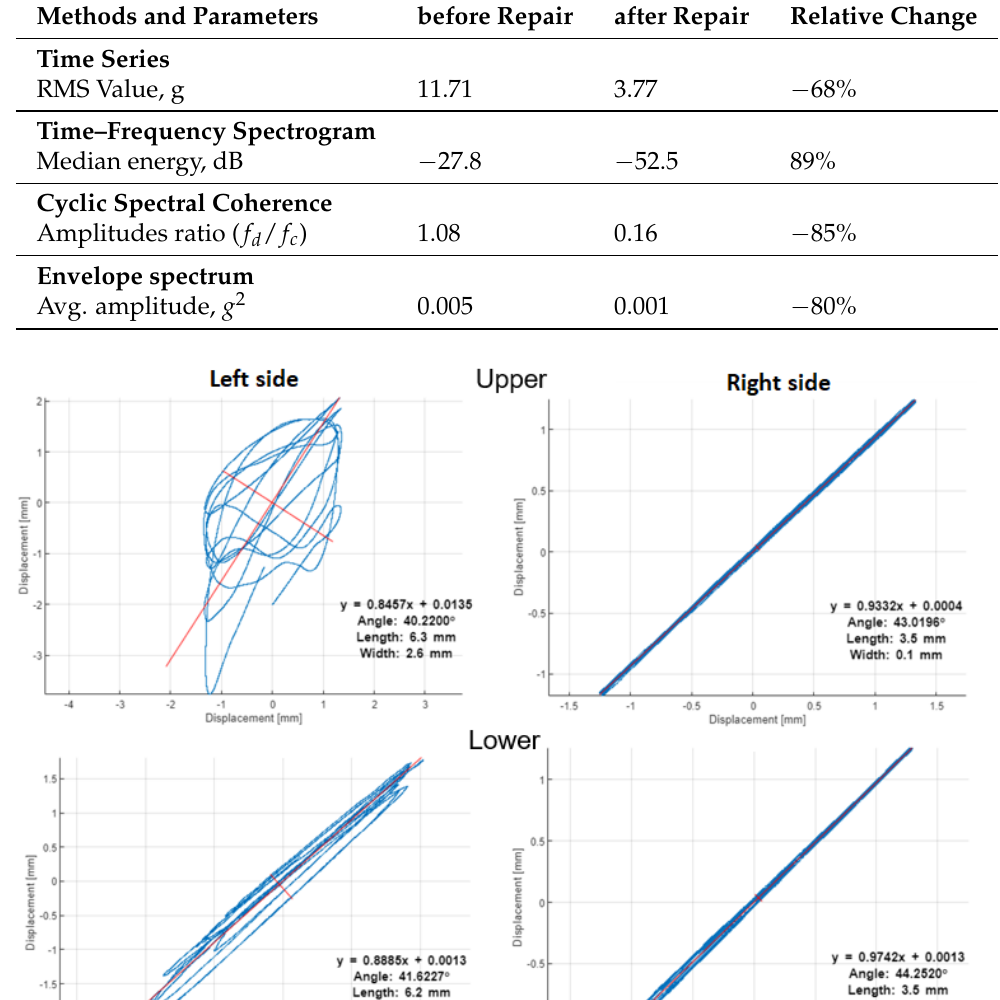
Table 1. Changes in parameters for different methods on the left side of the lower shaft (dam- aged bearing).